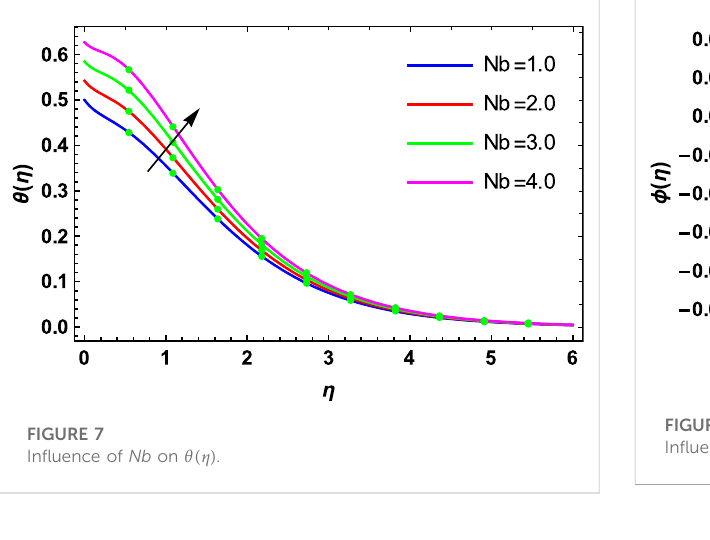
In fl uence of Nb on ϕ ( η ) .